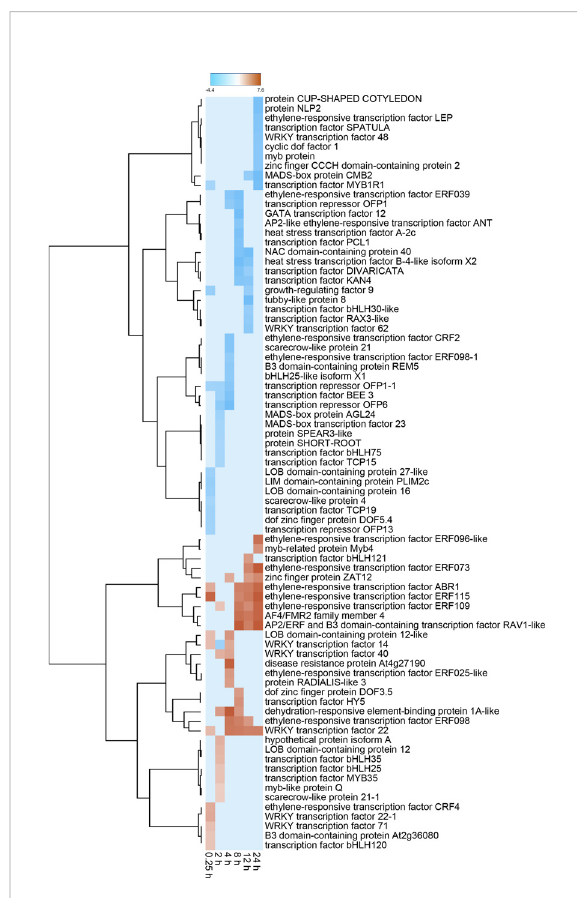
FIGURE 3 Heat map of changes in transcription factor (TF) gene expression in response to wounding. Differential gene expression is displayed as the log 2 fold change in gene expression between wounded and control roots at 0.25, 2, 4, 8, 12 and 24 h after wounding for striked out text should be replaced with: the ten most highly up- regulated and down-regulated TF DEGs from each time point. Genes are hierarchically clustered based on their pattern of differential expression over time.